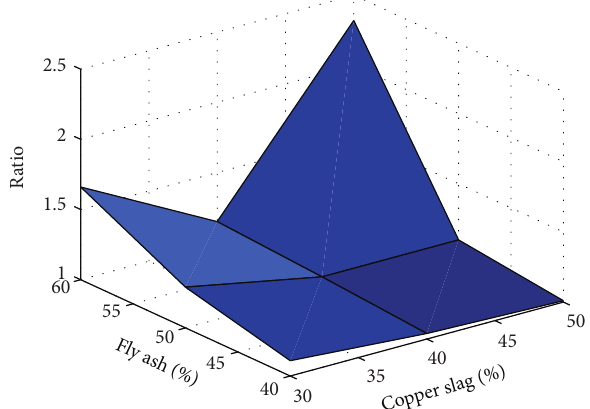
Figure 16: Results of experiment with steel and polypropylene fibres.